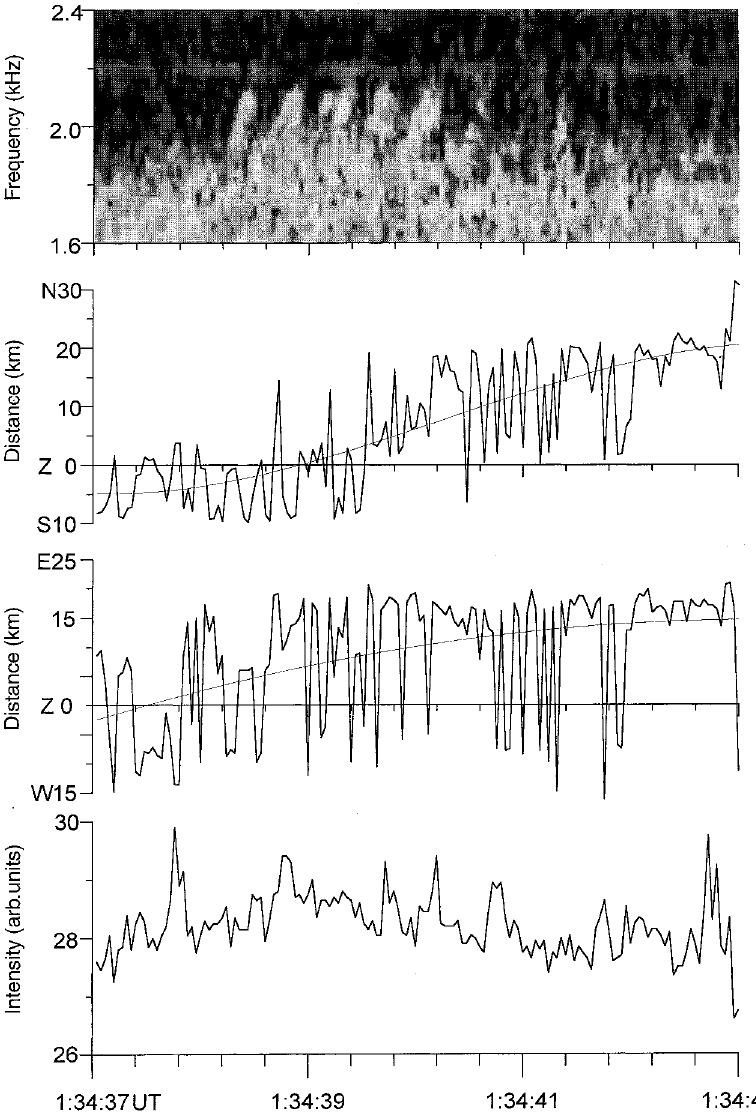
Fig. 7. Detail of the motion and intensity of the single pulsation, the first one from the set in Fig. 4. The whole time interval was 6 s from 01.34:37 to 01.34:43 UT. It is shown by black band in the third panel of Fig. 4. The first panel presents the dynamic spectrum of VLF emissions, the motion of luminosity maximum both in N-S and E-W directions are shown in the second and third panels , correspondingly. Fourth panel shows the intensity variations of luminosity maximum. Thin lines in the second and the third panels presents the averaged motion of